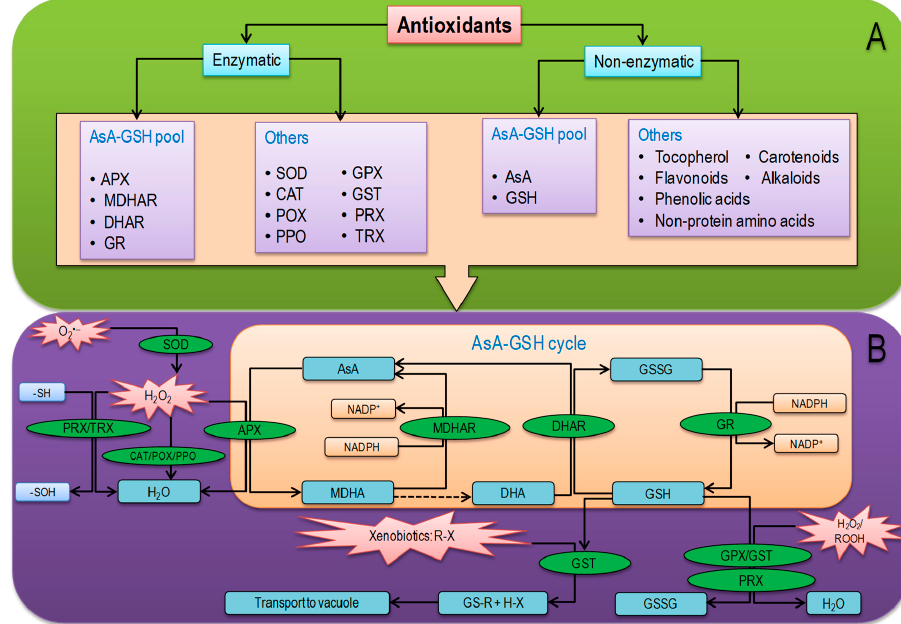
Figure 5. Overview of plant antioxidant defense system: ( A ) types of antioxidants and ( B ) combined